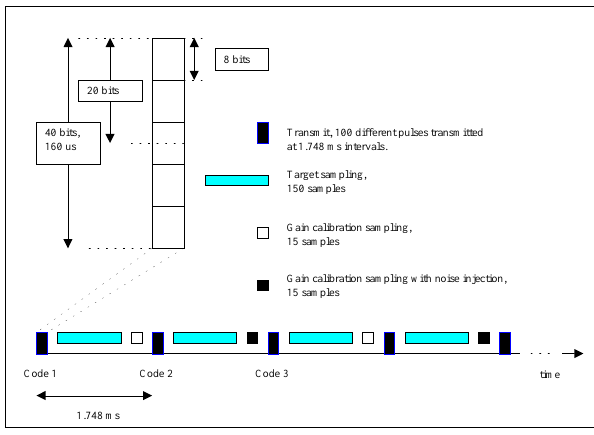
Fig. 1. Transmitted pulse structure and sampling arrangements.